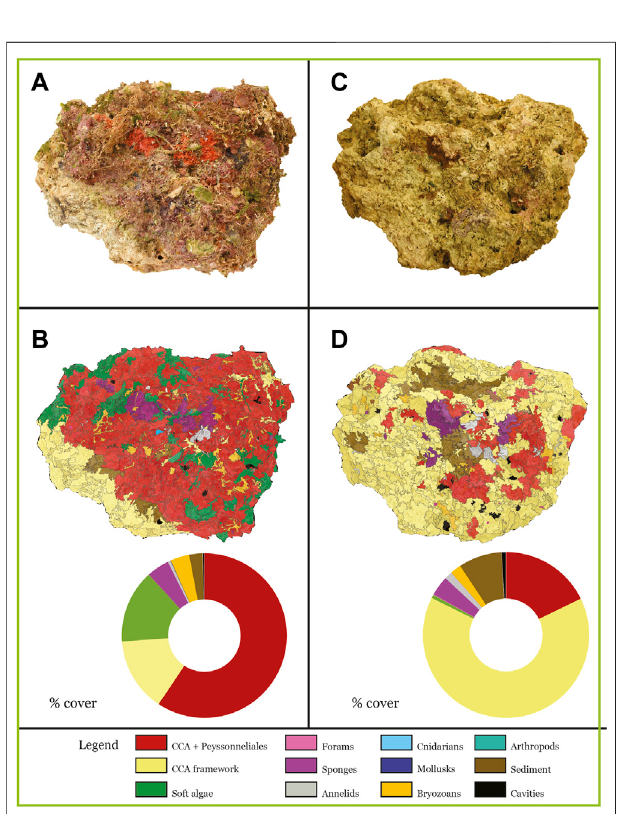
FIGURE 6 | North side of the sample CBR2_4_21c, pictured (A,C) and fragmented (B,D) . (A) Original north side; (B) results of the fragmentation of the north side with the ring chart of covers; (C) north side after the canopy removal; (D) results of the fragmentation of the north side after the canopy removal with the ring chart of